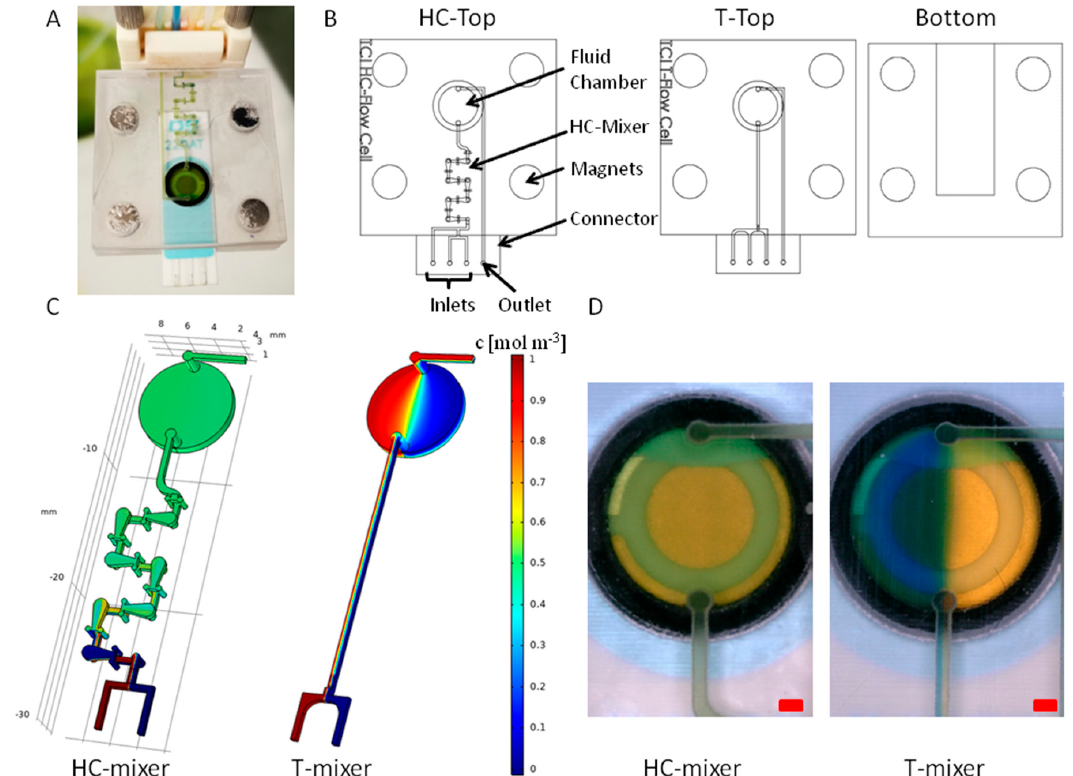
Figure 7. ( A ) Image of a 3D-printed dynamic flow cell with an integrated SPE. ( B ) computer-aided design (CAD) drawings of the top parts with HC-mixer and T-mixer and the bottom part of the flow cells. ( C ) COMSOL simulation of the interior structure of the dynamic flow cells (inlet flow rates of each 3 µL s -1 ). The left inlet and the right inlet were simulated with concentrations of 1 mol m -3 and 0 mol m -3 , respectively (see legend). ( D ) Pictures of the fluid chambers during mixing experiments with flow rates of 3 µL s -1 for both inlets. Yellow-colored solution was pumped into the left inlet and blue-colored solution into the right inlet. The red scale bar represents 1 mm width.